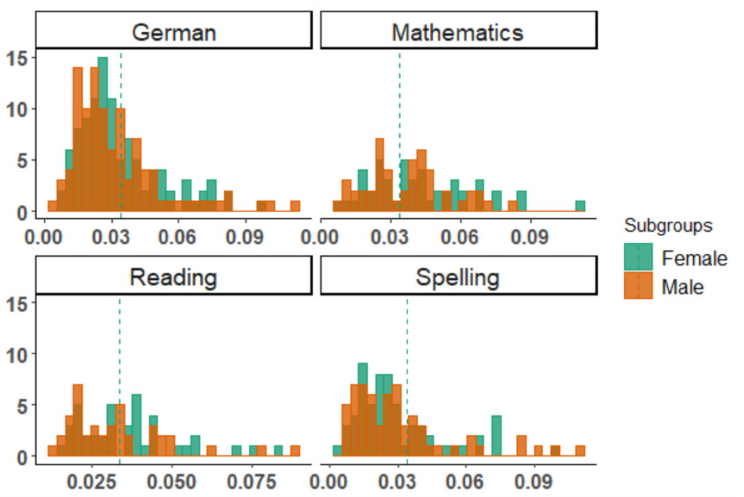
Figure 2. Empirical distribution of the RMSD for the items on the reading, spelling, German, and mathematics tests. The dotted line indicates the mean of the RMSD values for gender